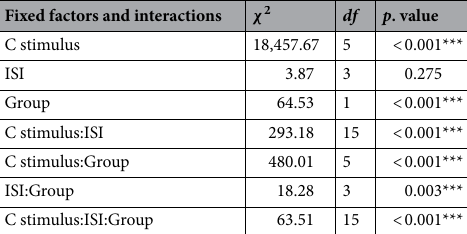
2 test on the best model explaining “C > S” responses. The C